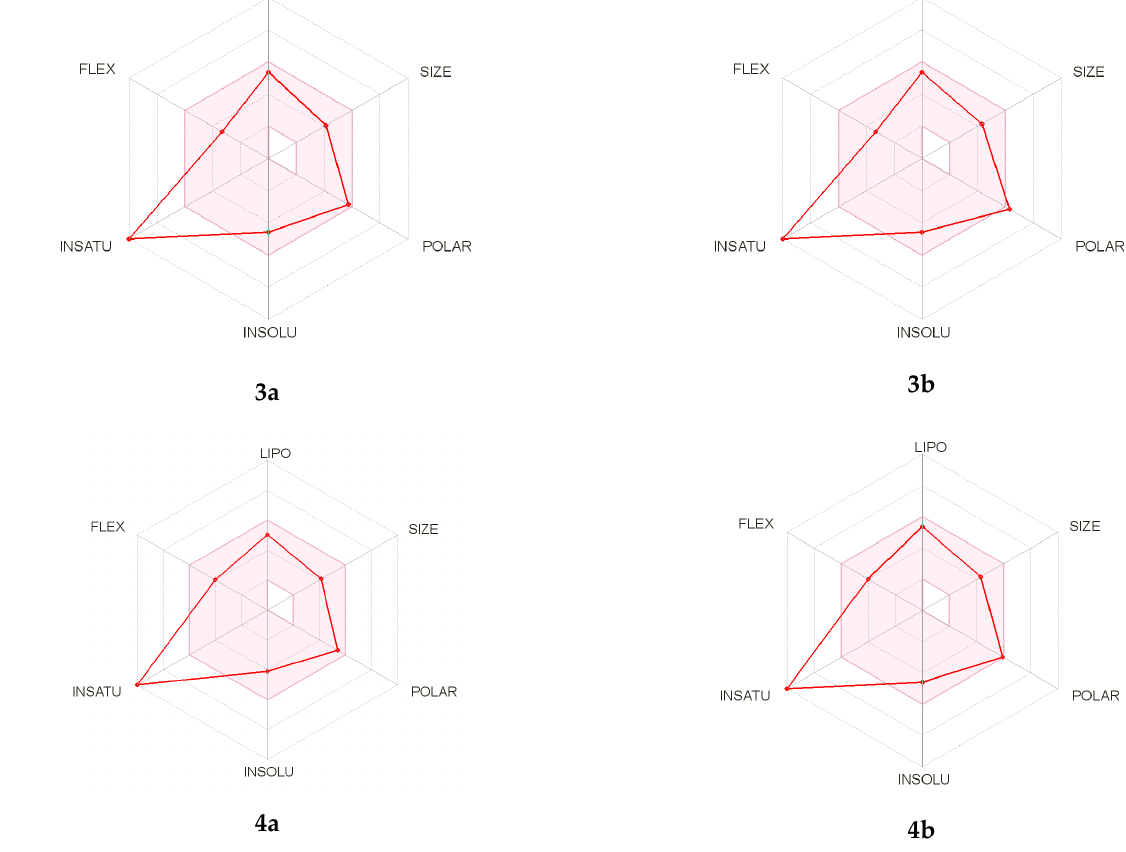
Figure 4. Bioavailability radars for 3a , 3b , 4a and 4b .